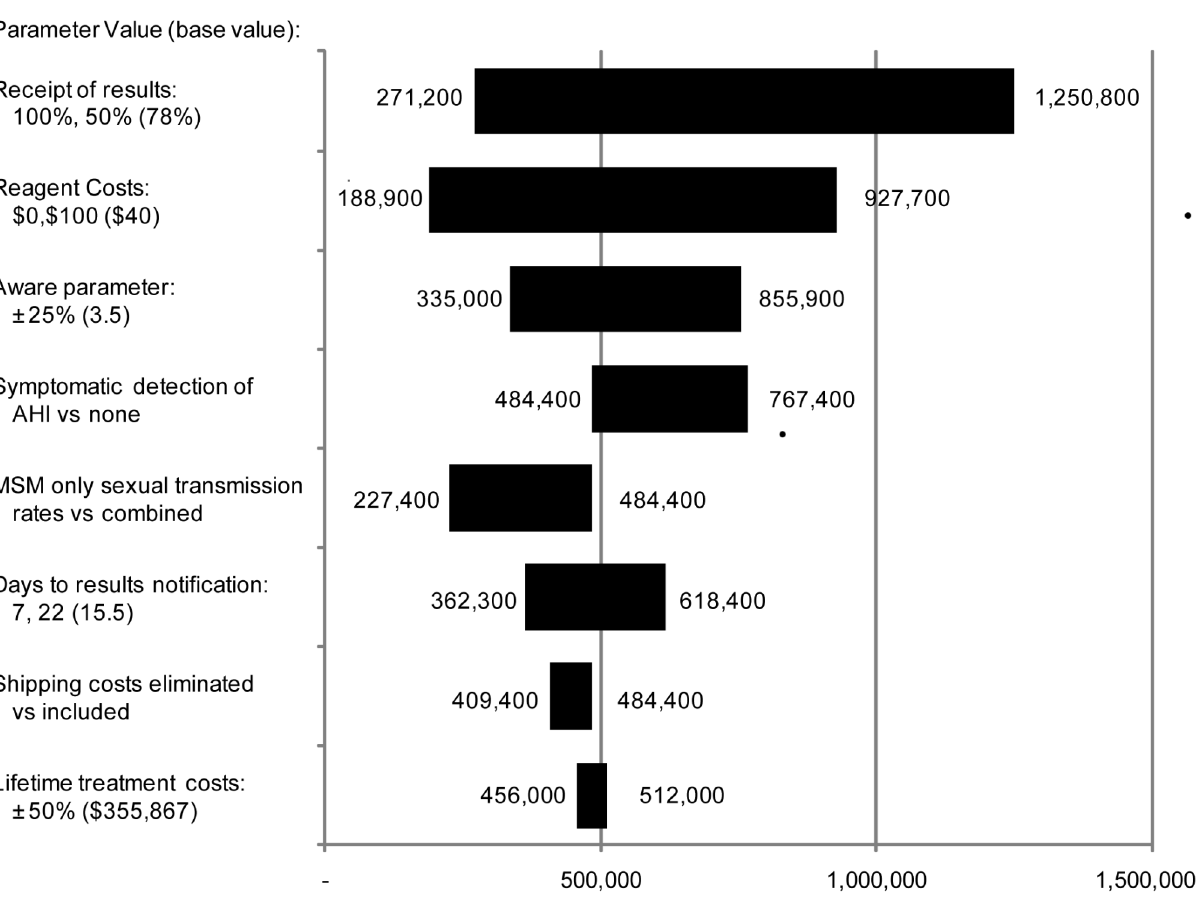
Figure 2. Tornado diagram of sensitivity analysis results. Based on municipal STD clinic data after third-generation EIA assuming a 1-y antibody retesting interval. Base case value = US $ 484,400 per QALY gained.